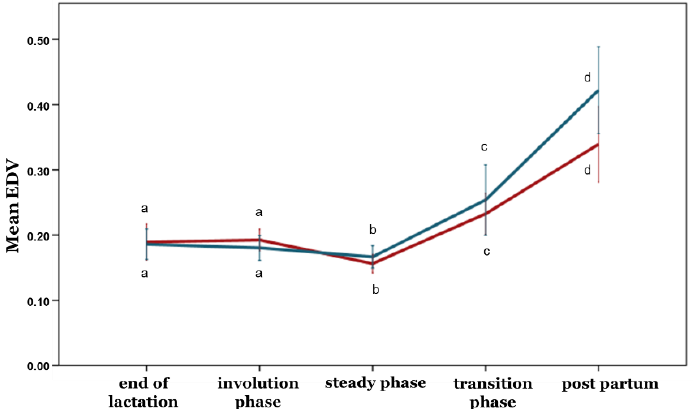
Figure 6. End-diastolic velocity changes among the periods and between the ewe groups ( p ≤ 0.05). The different letter indicators (a, b, c, d) represent statistically significant differences between the periods. The green line represents the ewe group with healthy udders, while the red represents the ewe group with subclinical mastitis.